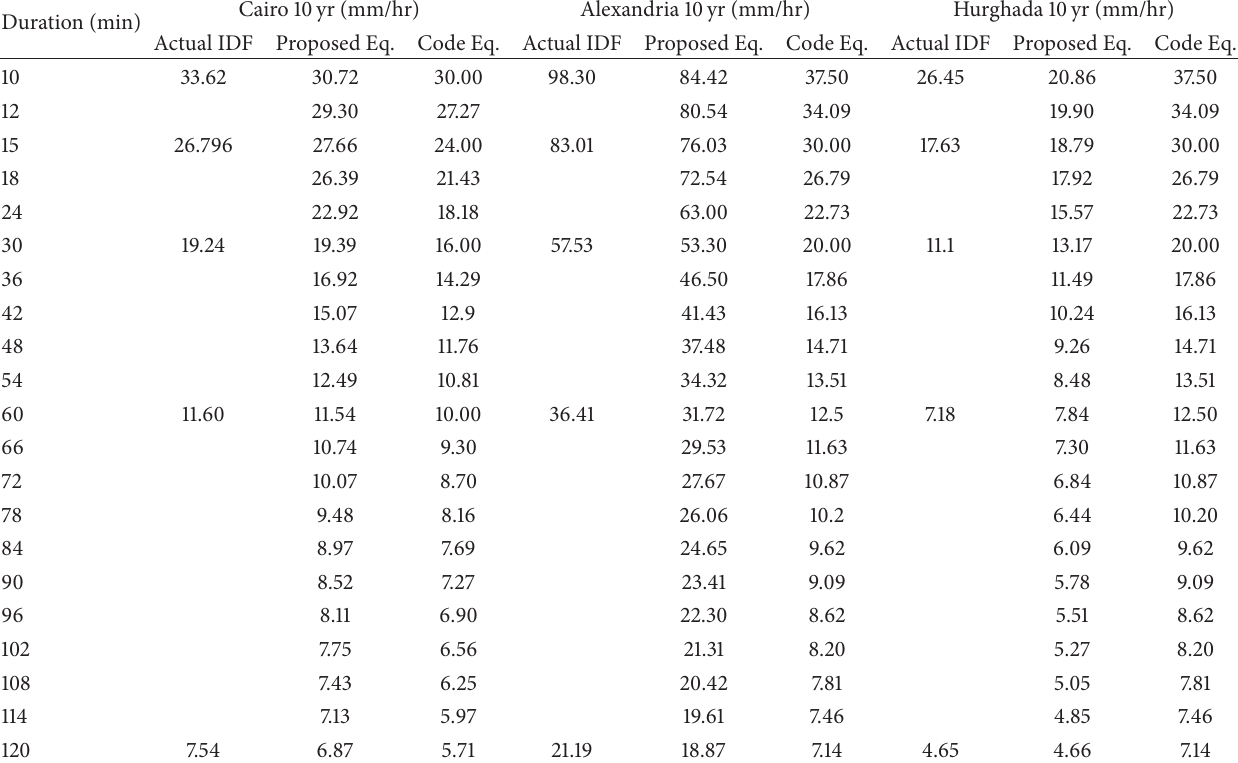
Table 6: Comparison of rainfall intensity 𝐼 (mm/hr) for various storm durationsfor Cairo, Alexandria, and Hurghada for the 10-year return